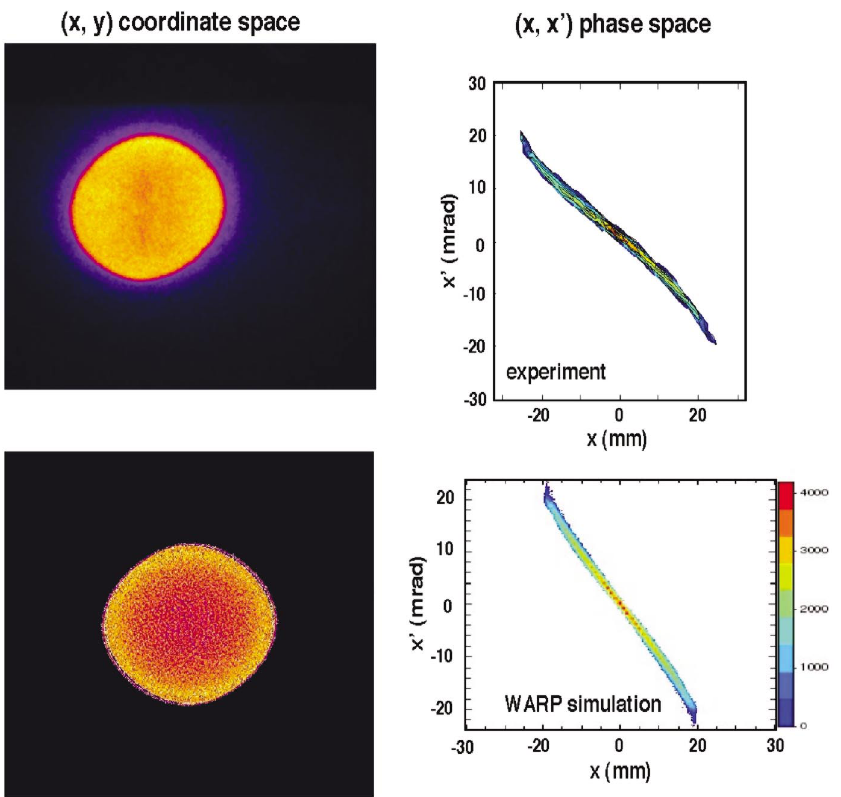
FIG. 8. (Color) Experimental results and simulations of beam profile and phase-space distribution at exit of channel.